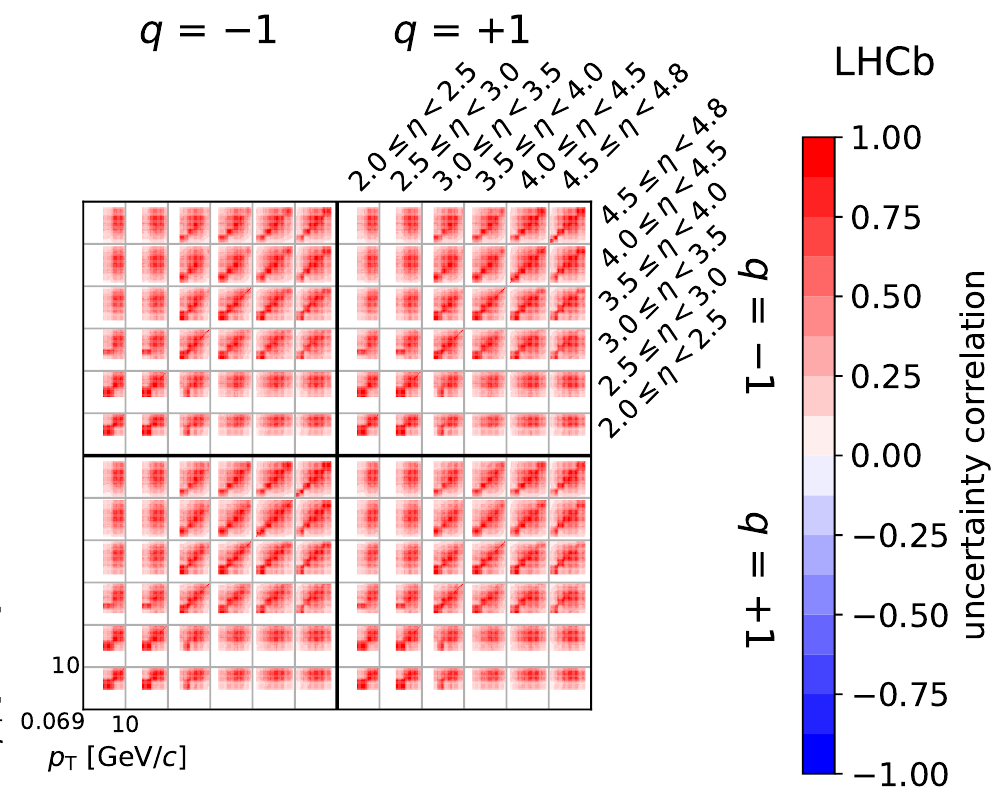
Figure 12 . Correlation matrix for the uncertainties of the differential cross-section of prompt inclusive production of long-lived charged particles. The four large quadrants correspond to the correlations between negatively and positively charged particles. The 36 cells within each quadrant correspond to the η intervals. In each cell, the correlations of the p T intervals are shown from low to high p T in logarithmic